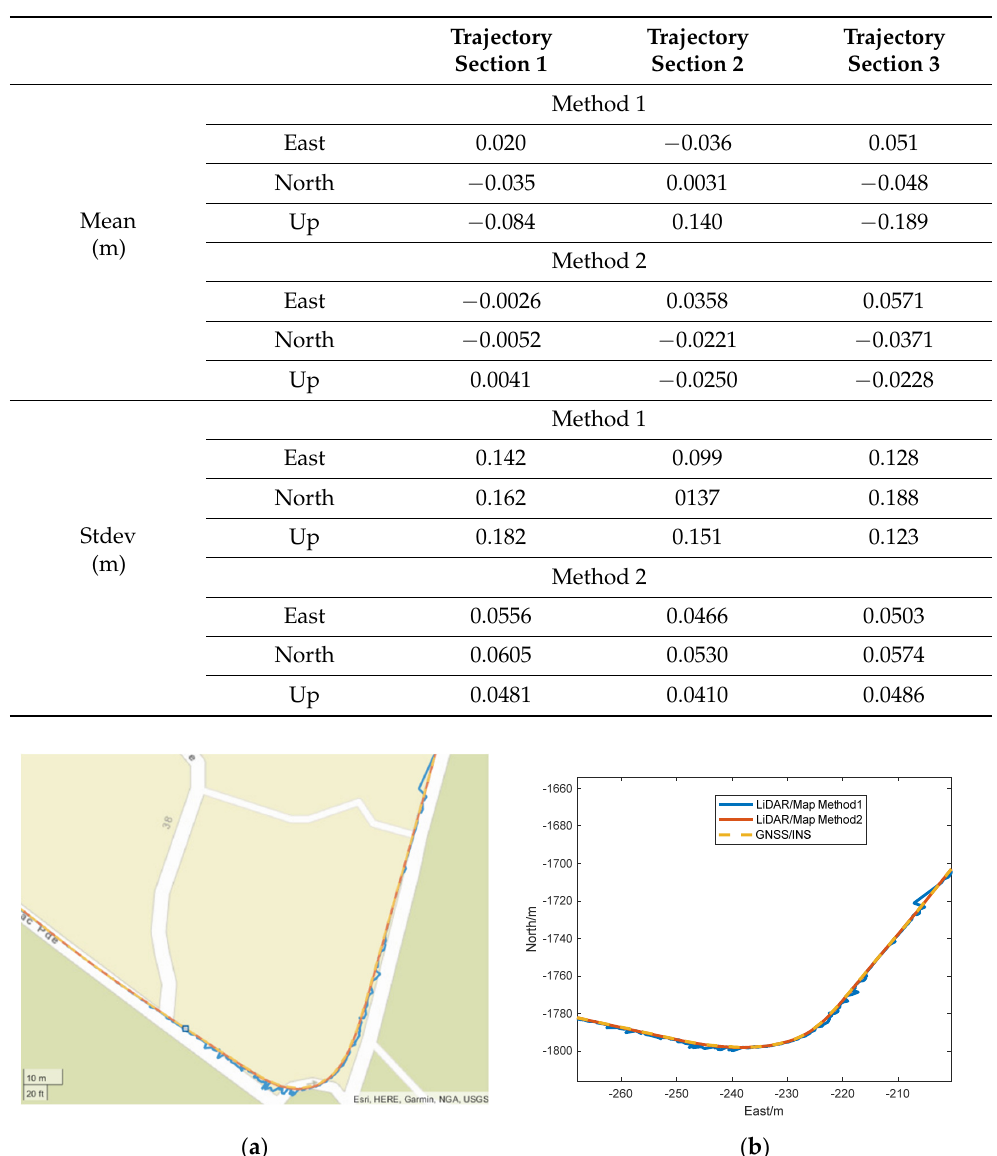
Table 3. Mean and standard deviation for the difference between Lidar/map matching-based localization and the reference GNSS/INS localization results, for Trajectory Sections 1, 2 and 3 in Figure 14. (a) Method 1: fusing IMU as an assistant sensor; (b) Method 2: fusing IMUs using the EKF-based tightly coupled method.